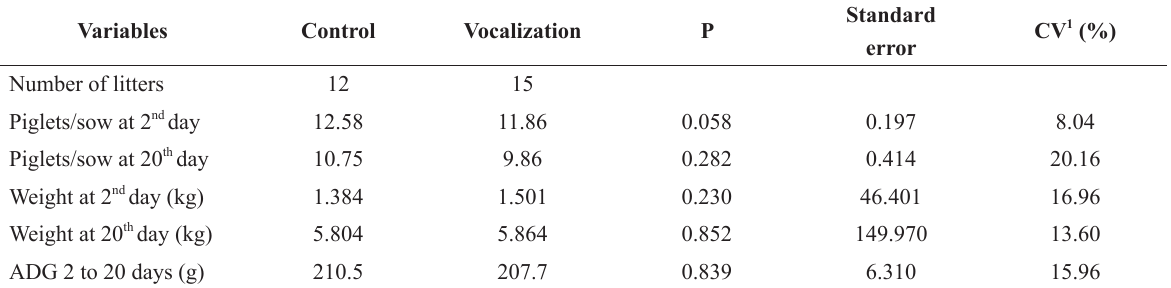
Live weight and daily weight gain of piglets due to the use of artificial vocalization of lactating sows.